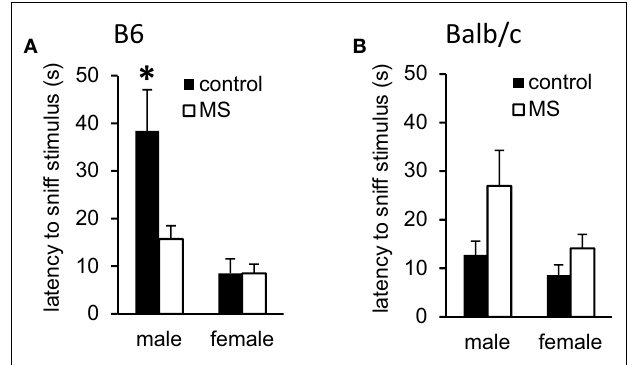
FIGURE 3 | Effects of MS-rearing on social behavior . Latency to sniff a novel mouse during dyadic social interactions was (A) decreased in MS-reared B6 males ( p < 0.01) with no effect observed on this measure in (B) Balb/c mice. * p < 0.05 (control vs. MS comparisons).